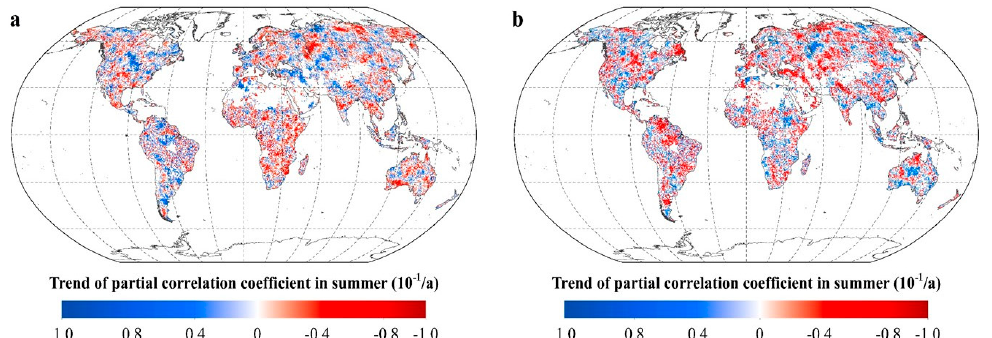
Figure 8. The response of vegetation greenness to the diurnal temperature in summer. ( a . spatial distribution of the temporal trend of the partial coefficients between summer NDVI and T max . b . spatial distribution of the temporal trend of the partial coefficients between summer NDVI and T min . Supplementary Table S3).